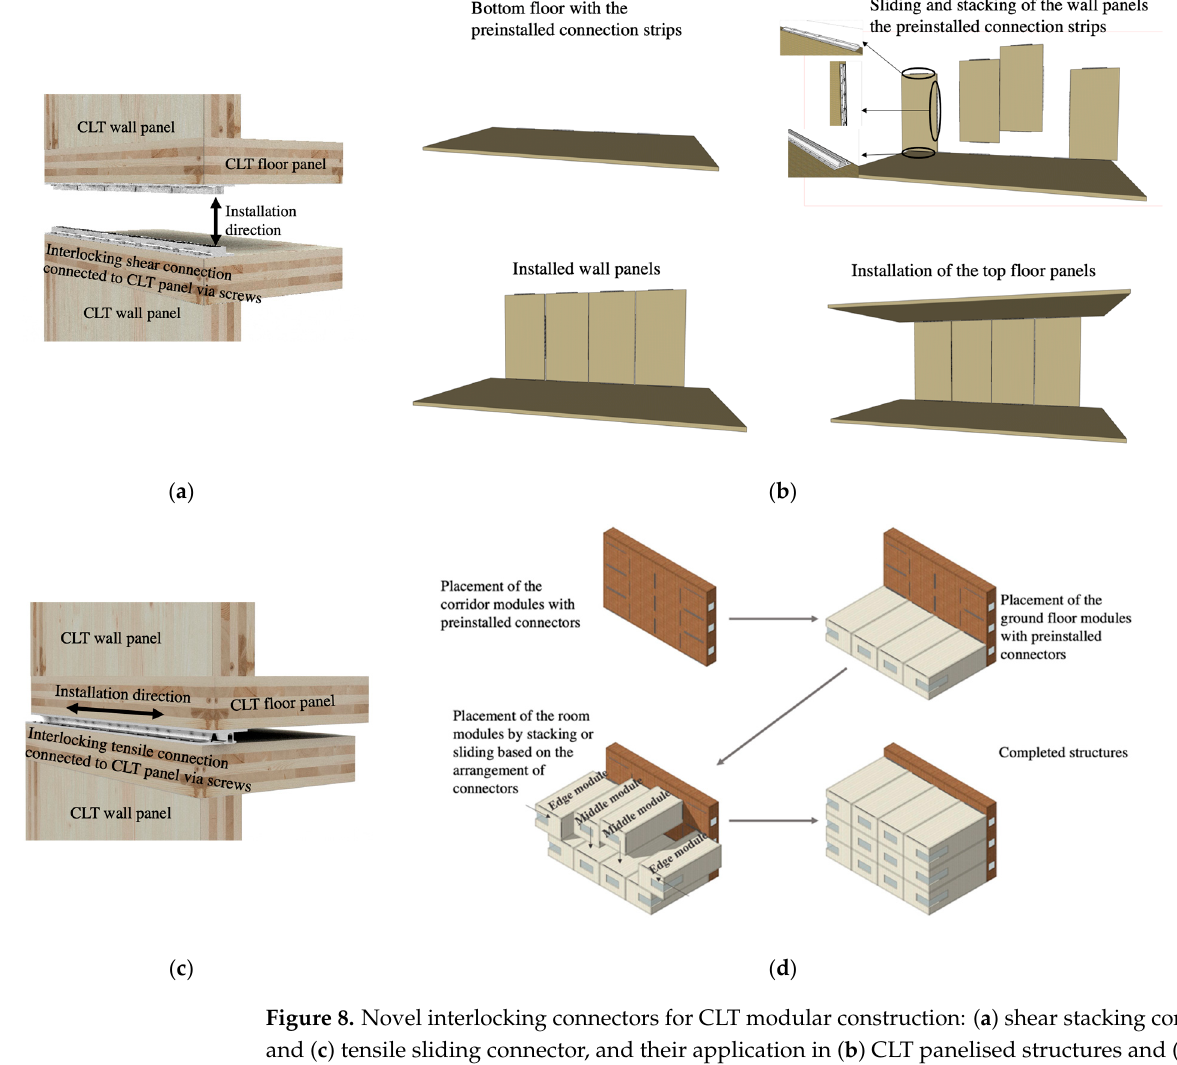
Figure 8. Novel interlocking connectors for CLT modular construction: ( a ) shear stacking connector and ( c ) tensile sliding connector, and their application in ( b ) CLT panelised structures and ( d ) CLT volumetric structures.